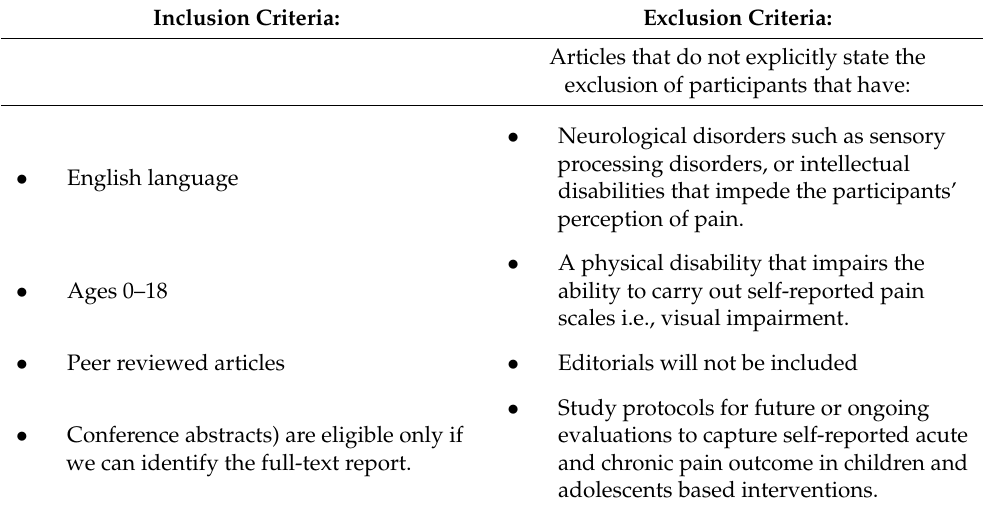
Table 2. Inclusion exclusion criteria.